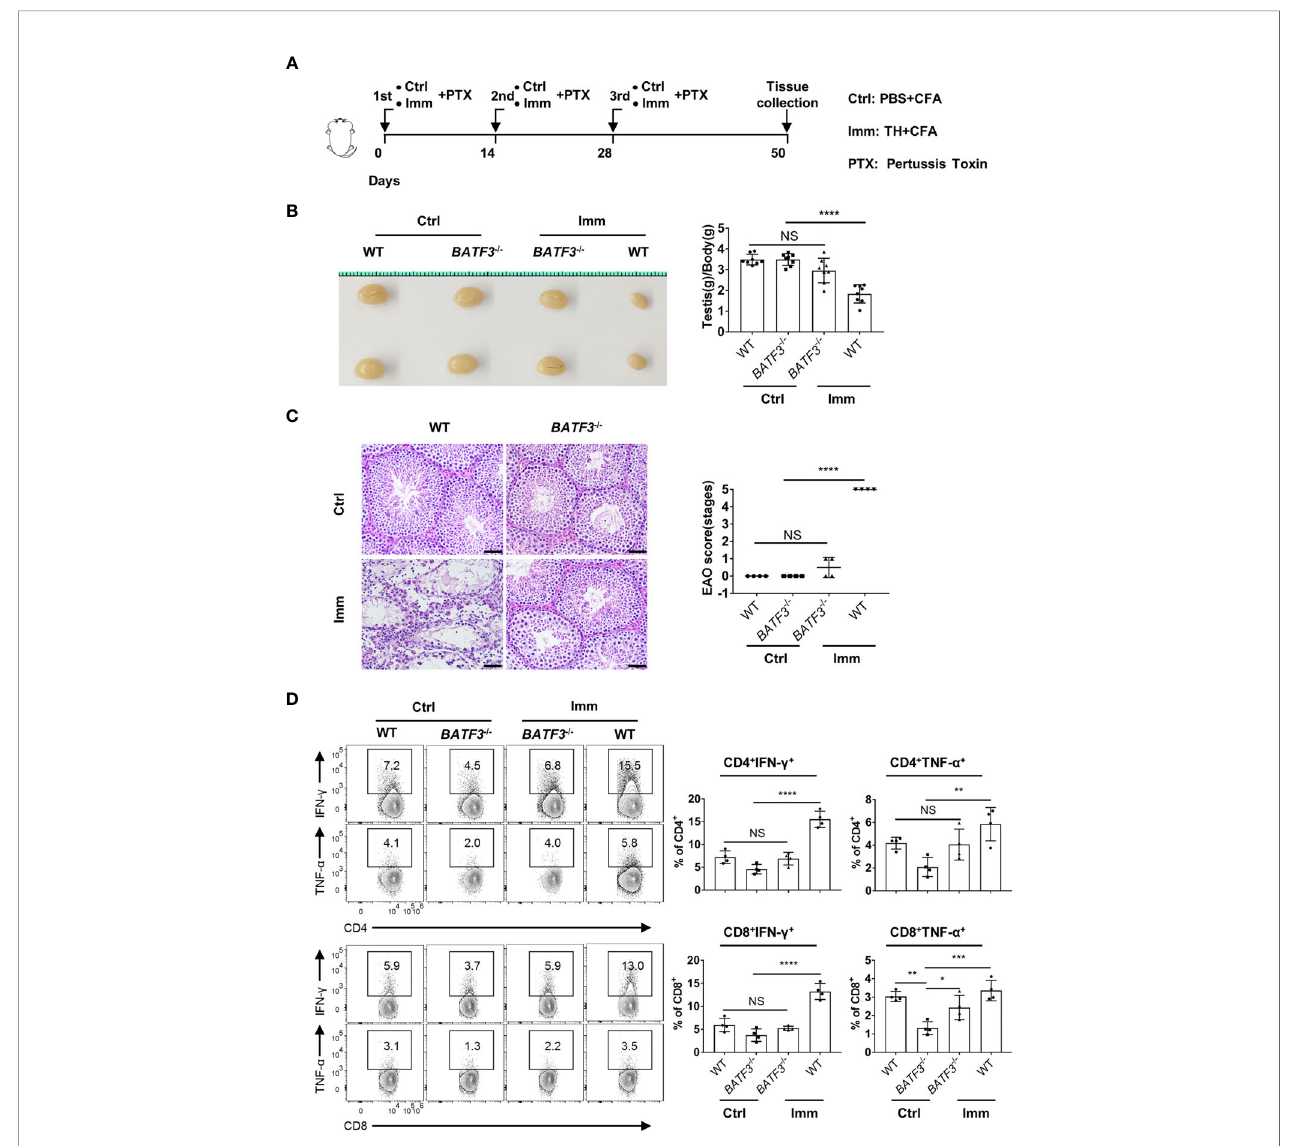
FIGURE 7 | cDC1 and T cells play a more important role in experimental autoimmune orchitis. (A) The schema depicts the experimental procedures of experimental autoimmune orchitis. WT and BATF3 − / − Mice were immunized three times with testicular homogenate (Imm group) or PBS (Ctrl group) emulsi fi ed in CFA. At 50 d after the fi rst immunization, the testis was collected for further experiments. (B) Gross morphology of representative testis from control and immunization mice, and relative weight of testis [testis weight (mg)/body weight (g)]. n = 8. Data were pooled from two experiments. Error bars are the mean ± SD. (C) Hematoxylin-Eosin- stained testis sections from control and immunization mice. Scale bar: 50 m m. EAO scores were evaluated based on methods in the previous research. EAO was scored by fi ve stages: stage 0, no detectable in fl ammation in the testis; stage 1, focal in fl ammation in the tunica albuginea; stage 2, focal in fl ammation adjacent to the tubuli recti; stage 3, in fl ammation surrounding the tubuli recti; stage 4, in fl ammation spreading around the seminiferous tubules and mild damage of the seminiferous epithelium; and stage 5, severe in fl ammation surrounding the tubules and damage of the seminiferous epithelium. (D) FACS analysis of the percentage of IFN- g - and TNF- a -producing CD4 + and CD8 + T cells in the testis of indicated mice. (C, D) n = 4. Data are representative of two experiments. Error bars are the mean ± SD. One-way ANOVA with Tukey ’ s multiple comparisons test was performed. *P < 0.05; **P < 0.01; ***P < 0.001; ****P < 0.0001; NS, not signi fi